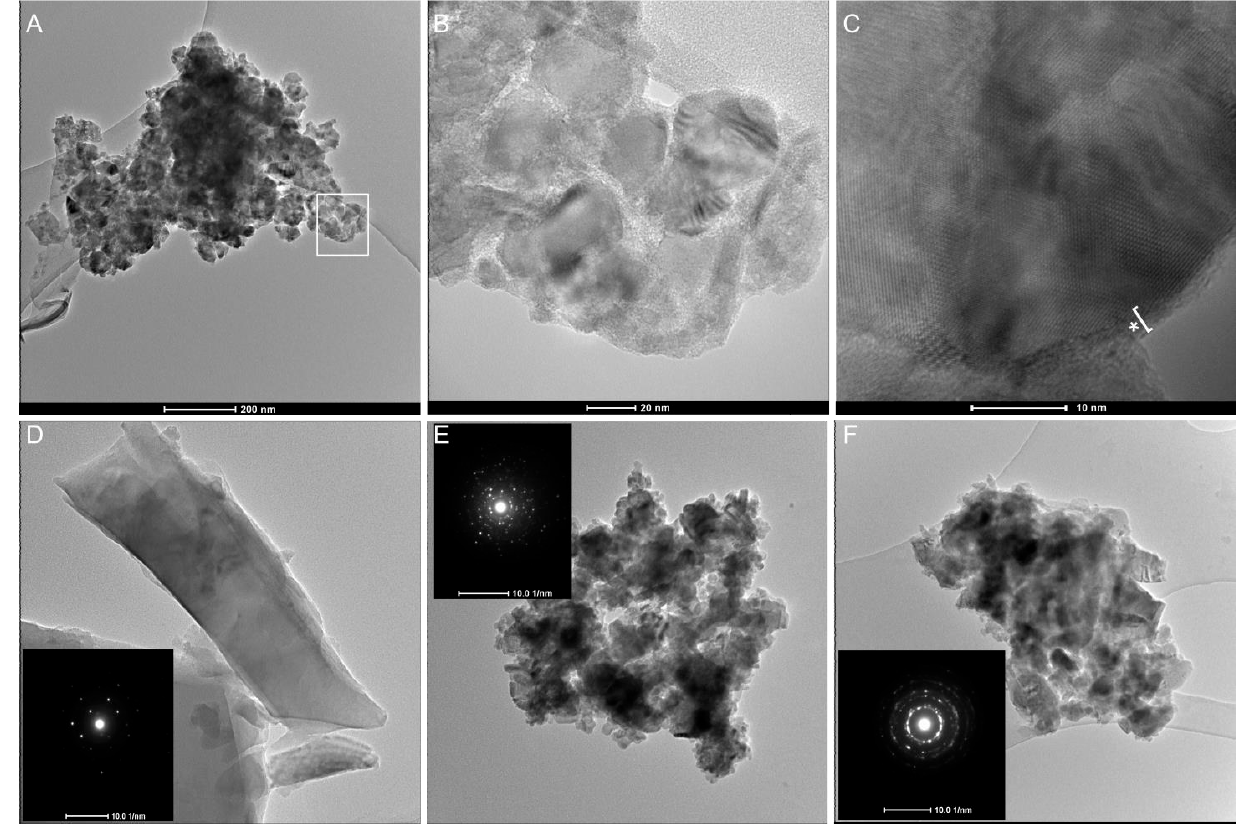
Figure 6. Transmission Electron Microscopy (TEM) of gQ-n3 after dispersion in ultrapure water and probe sonication. Large agglomerates of 20–30 nm quartz nanoparticles are evidenced at low mag- nification ( A ). The particles in the highlighted white square are imaged at higher magnification ( B ). High-resolution image of a portion of the agglomerated quartz ( C ) highlights crystalline core, with several diffraction planes visible, and the amorphous external layer (indicated by the asterisk) formed during high-energy milling. A larger submicrometric highly crystalline quartz particle (( D ), SAED in the inset). Nanometric agglomerates of milled quartz at low magnification and their corresponding large-field SAED evidenced multiple reflections and rings that indicate a nanometric size of the primary particles (( E , F ), SAED in the inset).